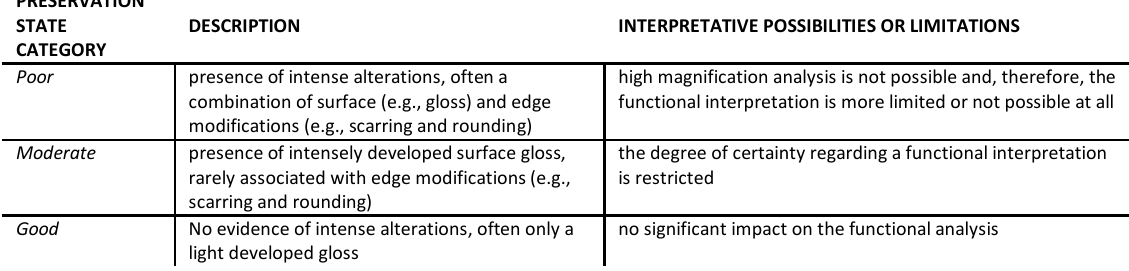
Table 4 . Different categories of preservation and their implications for functional